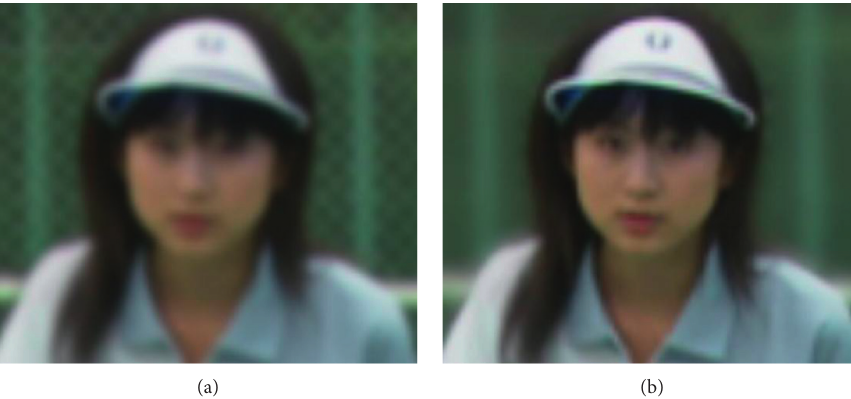
Figure 6: The comparison charts of ROI in detail. The compressed result of (a) K0103 algorithm and (b) ORC algorithm.